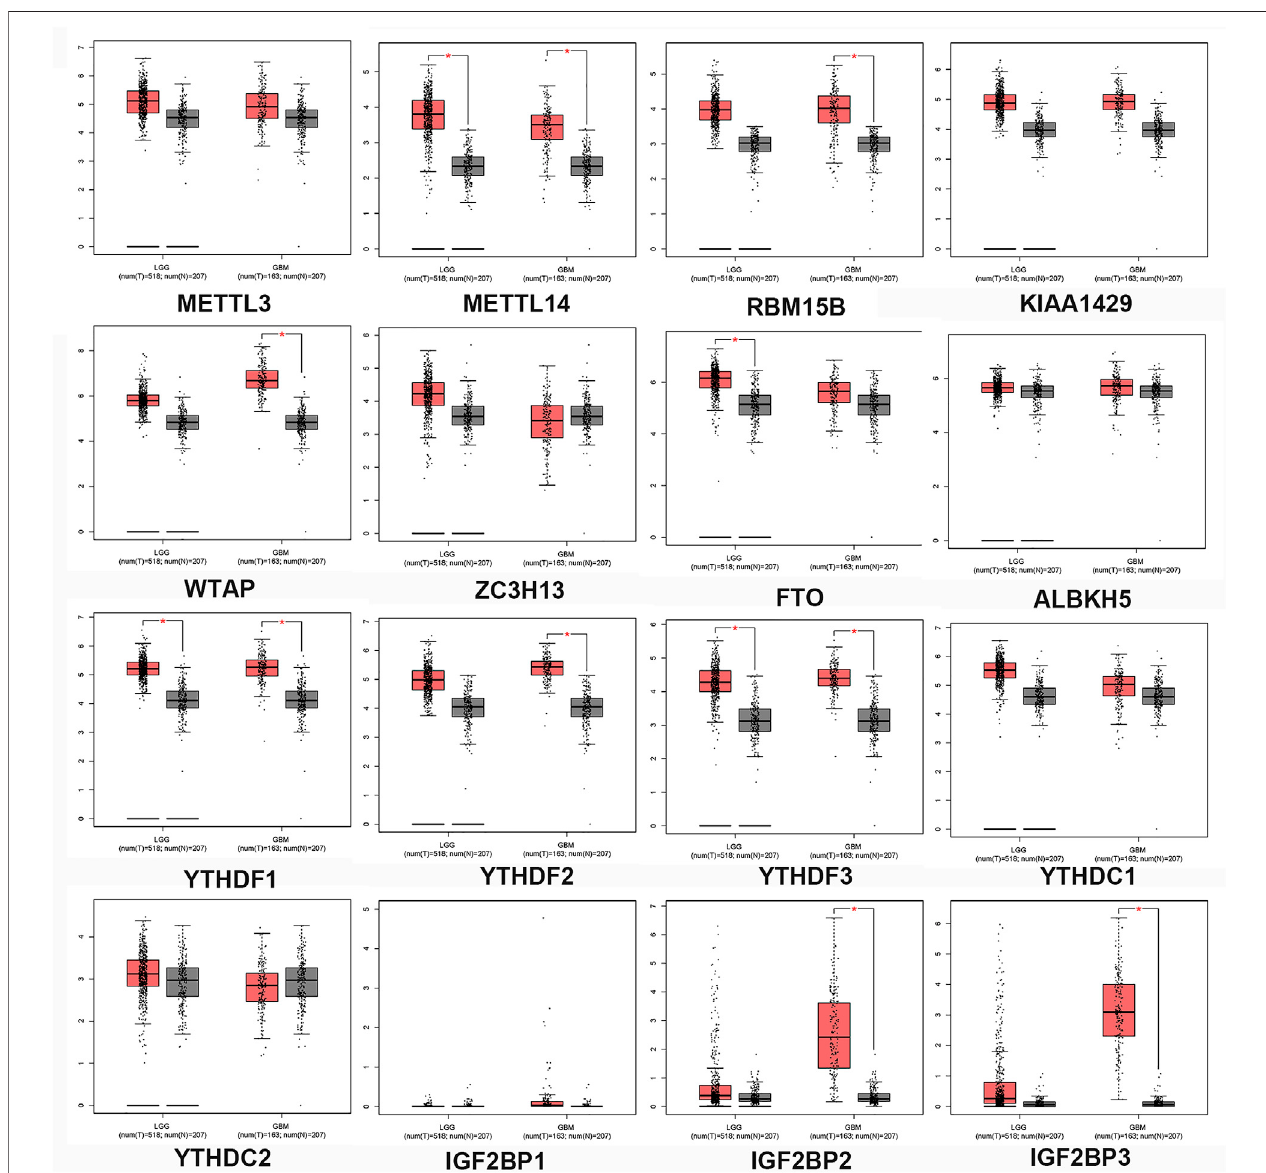
FIGURE2| Expressionpro fi lesofthem 6 A-relatedgenesingliomas.ThemRNAexpressionofm 6 A-relatedgeneswasanalyzedusingTCGA-LGGandTCGA-GBM datasets through GEIPA. T, Tumor tissues; N, normal tissues. p < 0.05, versus noncancerous brain tissues.